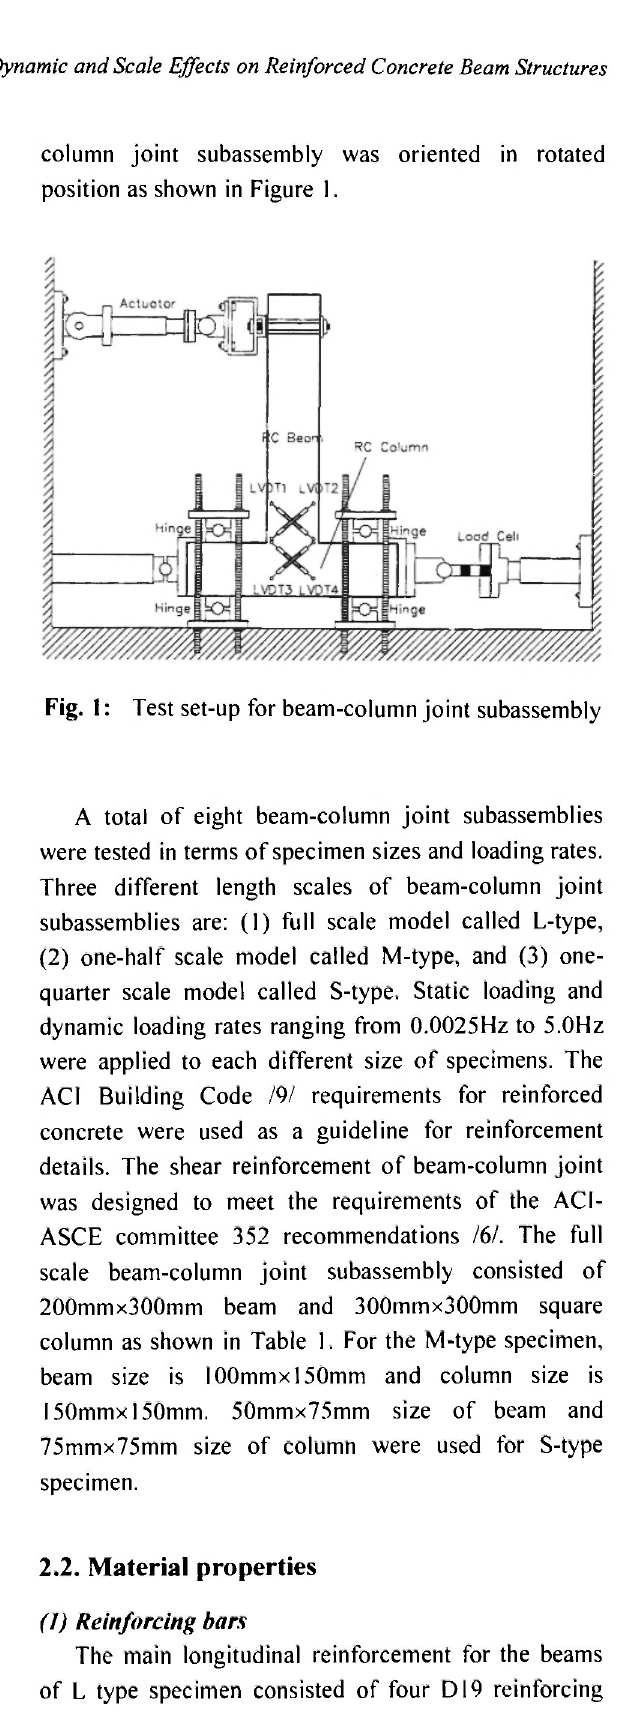
bars. The bottom bars were bent up into the column